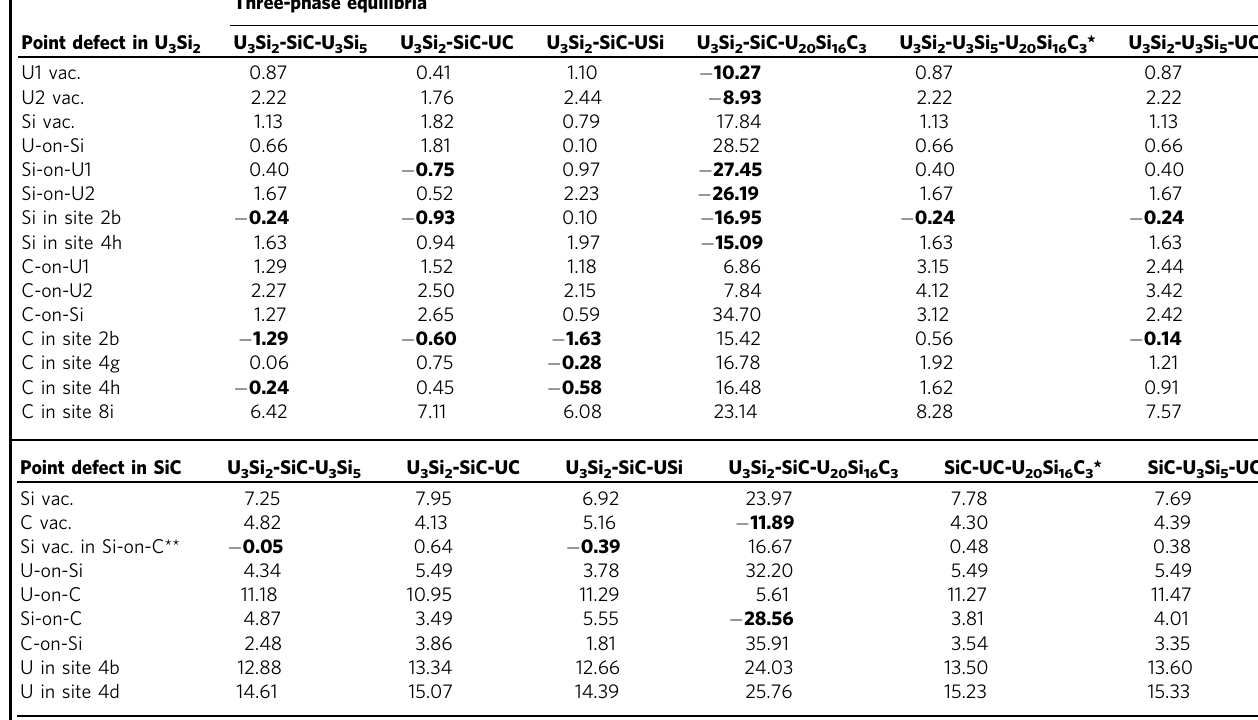
Defect formation energies ( Δ E D f ) in eV/defect atom, in U 3 Si 2 at chemical potentials governed by the indicated three-phase equilibria. Negative Δ E D f values are shown bold. * Fuel and cladding not in contact. **Si-on-C anti-site with vacancy on Si